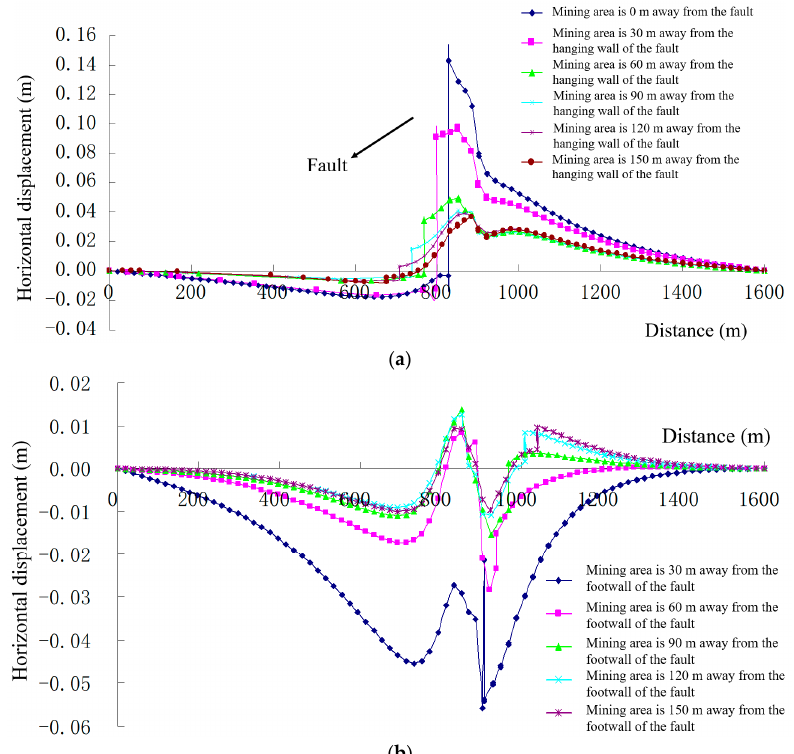
Figure 5. Line chart of horizontal displacement distribution of surrounding rock on monitoring line at different distances from the mining area to the fault, they should be listed as: ( a ) The mining area is located in the fault hanging wall; ( b ) The mining area is located in the fault footwall.